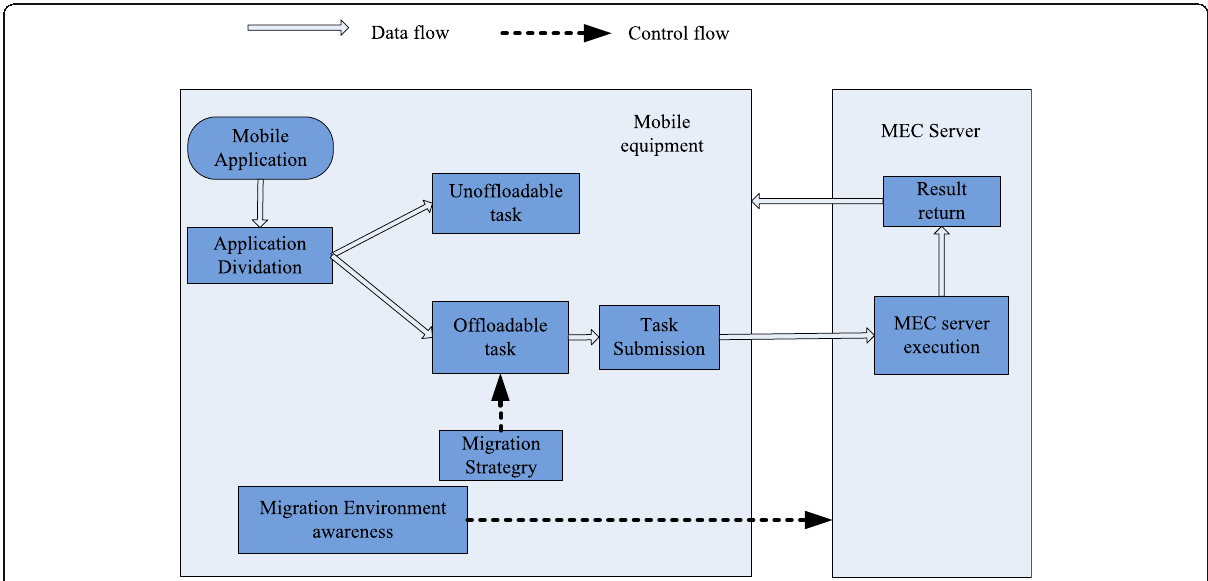
Fig. 1 Task migration flow chart. The task migration of mobile edge computing mainly includes six steps: environment awareness, task division, migration decision, task upload, edge server execution, and result return. Among them, task partitioning and migration decision are two core